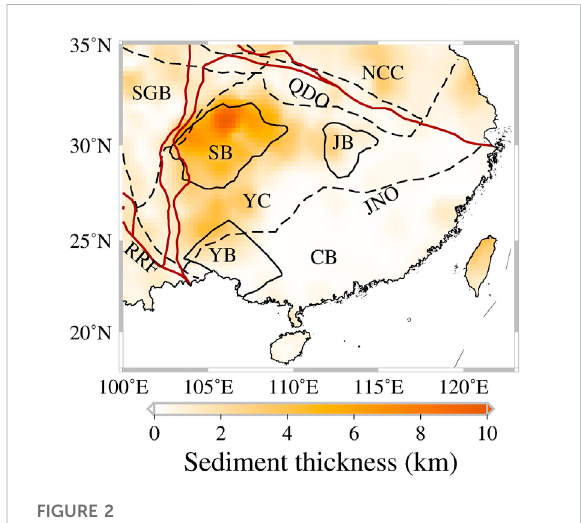
The thickness of sediments in the South China Block is based on the study of Laske et al. (2013) and Xiao et al.